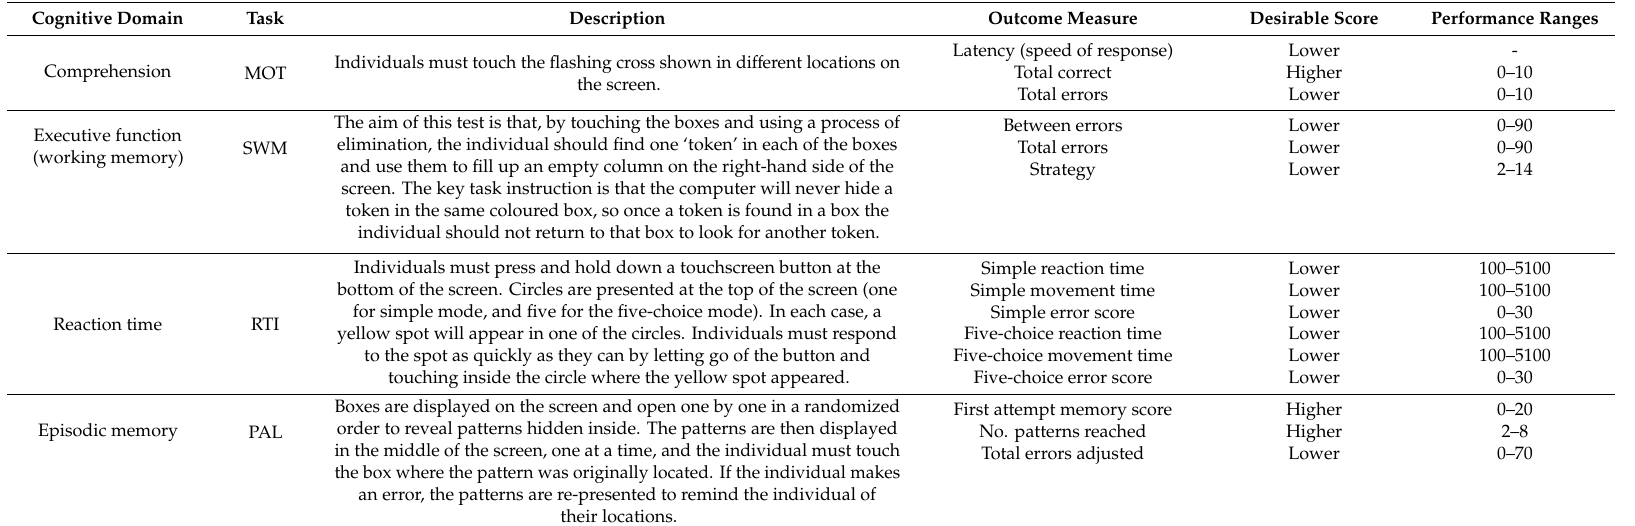
Table 1. Tasks performed in CARES to assess cognition using the Cambridge neuropsychological test automated battery (CANTAB). Cognitive Domain Task Description Outcome Measure Desirable Score Performance Ranges Latency (speed of response) Lower ff erent locations on Comprehension MOT Individuals must touch the flashing cross shown in di Higher the screen.